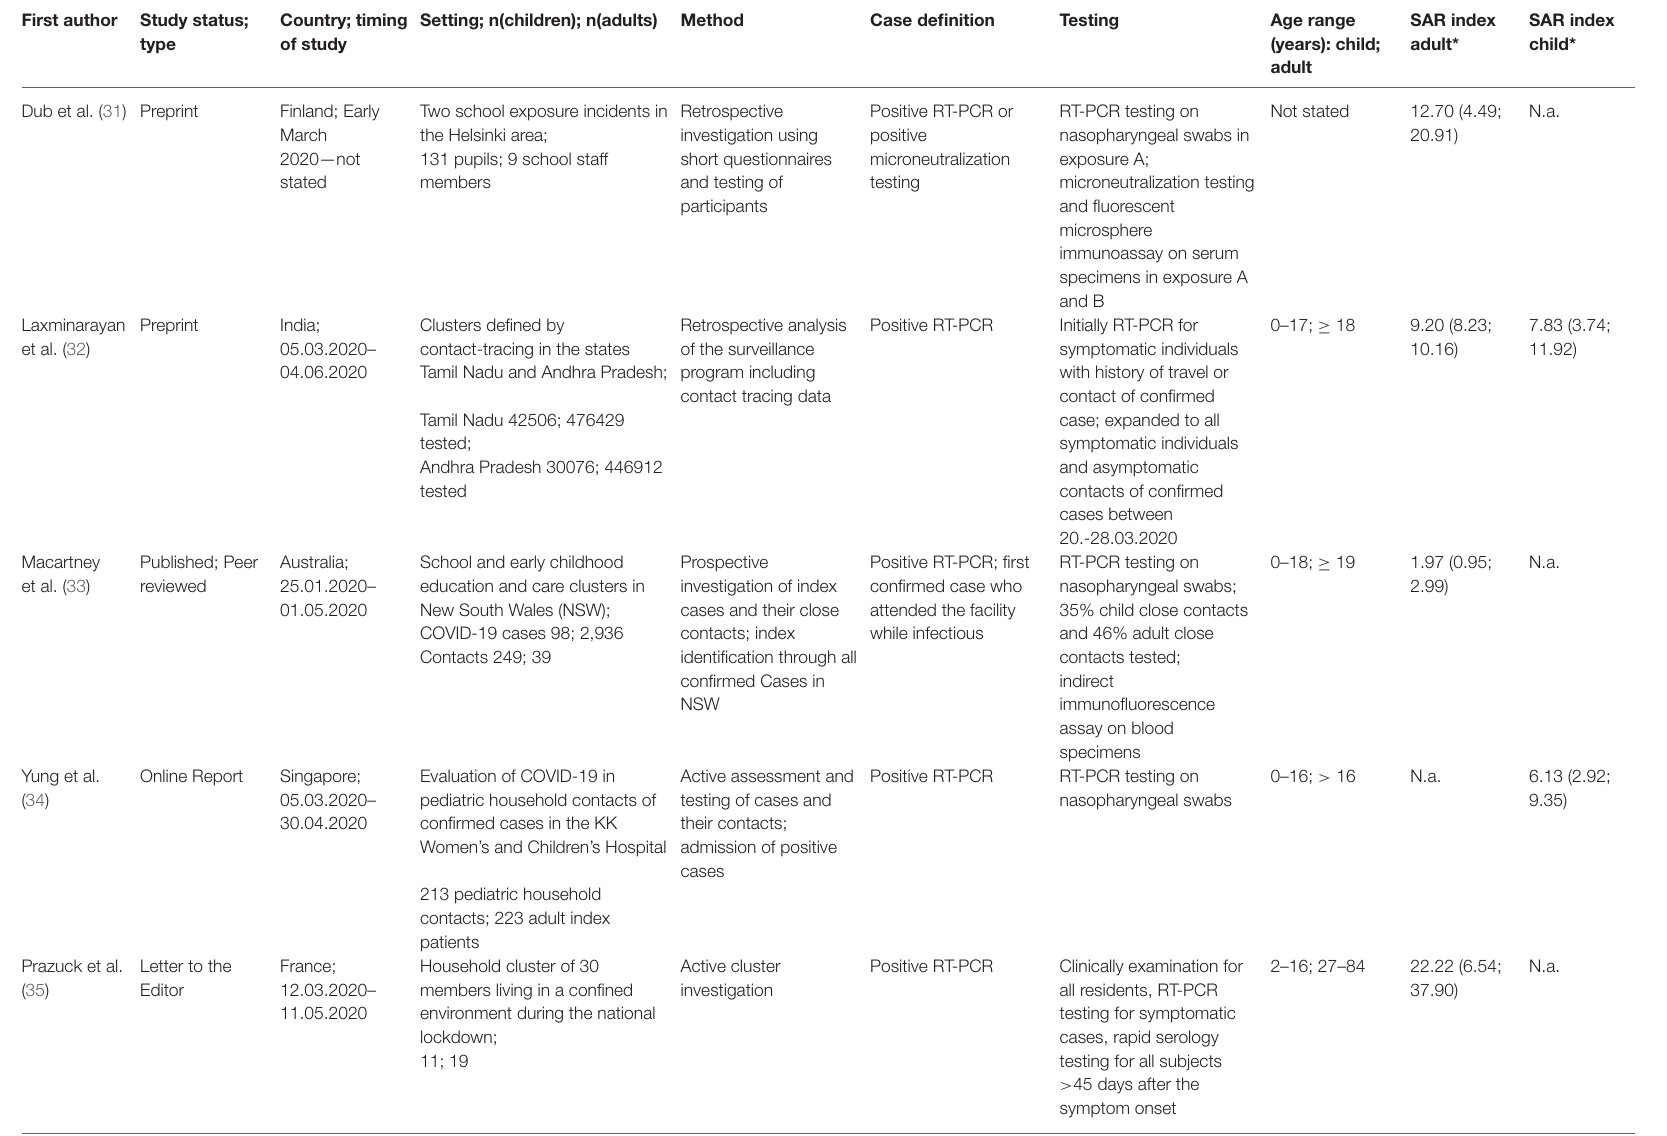
TABLE 1 | Characteristics of studies included in quantitative analysis and their main important findings and